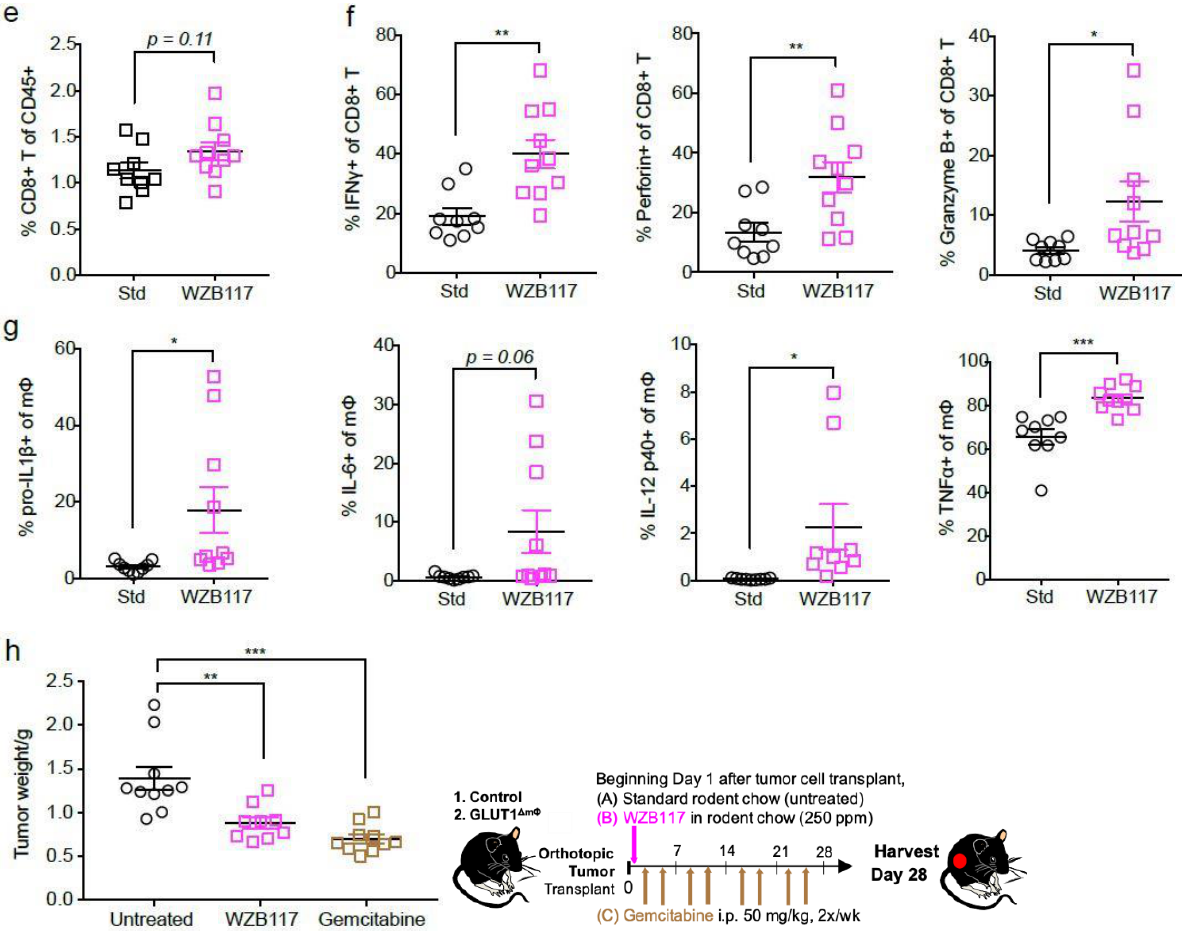
Figure 5. The GLUT1 inhibitor WZB117 attenuates tumor burden in vivo. WZB117 (250 ppm) was fed to mice beginning Day 1 of orthotopic transplantation of tumor cells. Disease progression was monitored in vivo, and immune parameters were assessed in the pancreatic tumors. ( a ) Scatter plot of the total flux on Day 26 of mice fed with standard (“Std”) rodent chow (black) (n = 9) or WZB117-incorporated chow (magenta) (n = 10) as calculated from BLI images. ( b ) The same mice from ( a ) were euthanized and shown is a scatter plot of their tumors weighed at Day 34. Tumor images are shown on the right hand side. Scale bar = 1 cm. ( c – g ) Shown are scatter plots of the % NK of total CD45+ cells ( c ), % IFN γ +, % Perforin+, and % Granzyme B+ of NK cells (d), % CD8+ T of total CD45+ cells ( e ), % IFN γ +, % Perforin+, and % Granzyme B+ of CD8+ T cells ( f ), % pro-IL1 β +, % IL6+, % IL12p40+, and % TNF α + (g) of total macrophages. Data representative of two independent experiments, with n = 9–10 mice per group. ( h ) WZB117 was compared head to-head with standard-of-care gemcitabine. Gemcitabine was injected 50 mg/kg i.p., twice a week, beginning the first week. Shown is a scatter plot of tumors from mice fed standard rodent chow (“untreated”) (black), WZB117-incorporated chow (magenta), or treated with gemcitabine (brown) weighed at Day 28. Data representative of two independent experiments, n = 10 mice per group. Data are means ± SEM, * p < 0.05; ** p < 0.01; *** p < 0.001 by unpaired student’s t-test with 95% confidence interval.